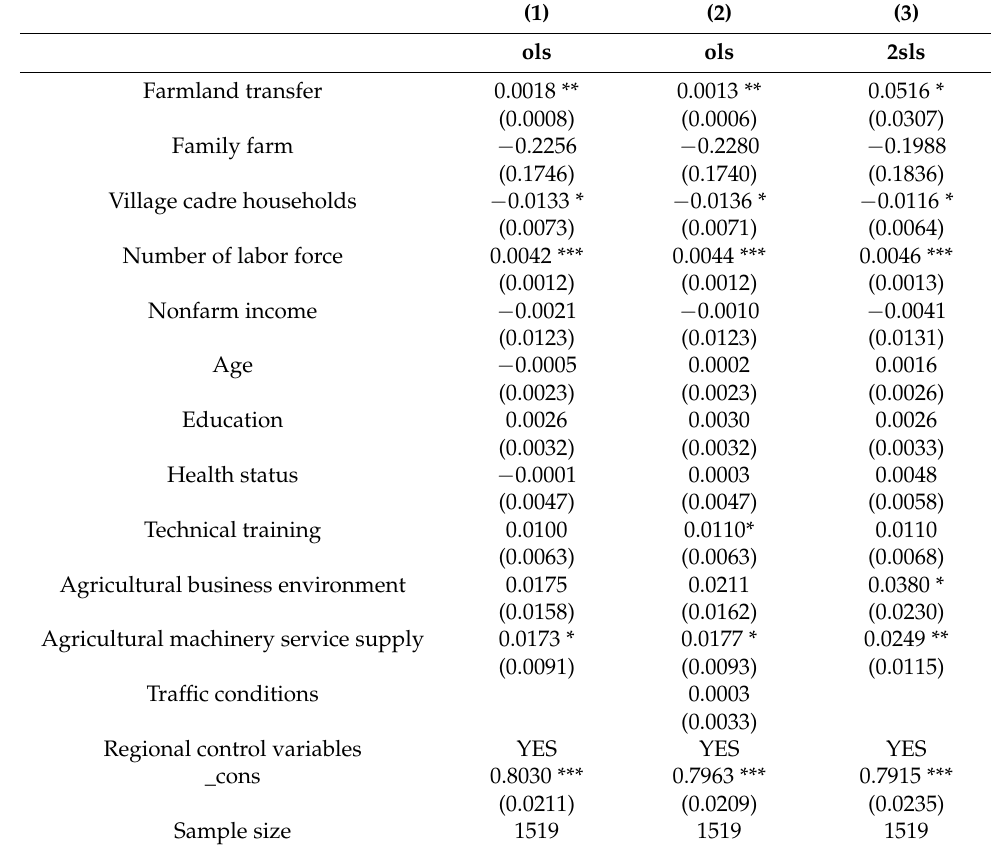
Table 3. Effect of farmland transfer on farmers’ technical efficiency